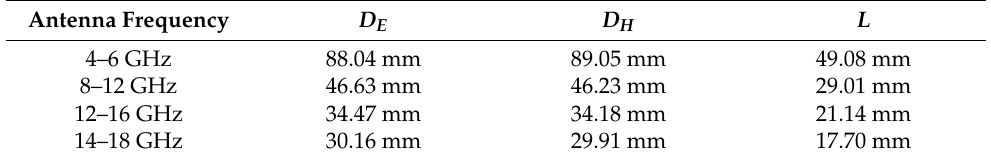
Table 2. The size of the corresponding pyramid horn antenna designed. L is the length of the antenna.